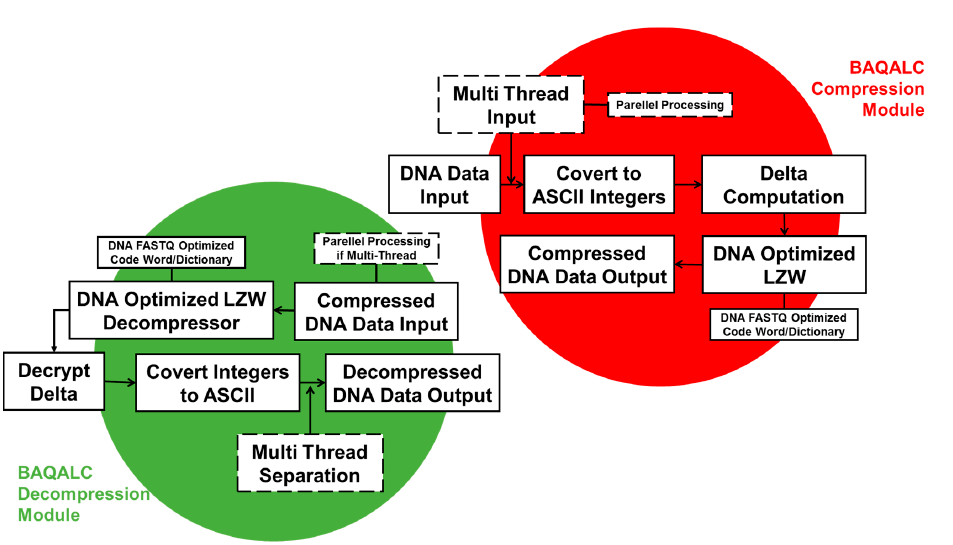
Figure 3. BAQALC Compression and Decompression Modules.